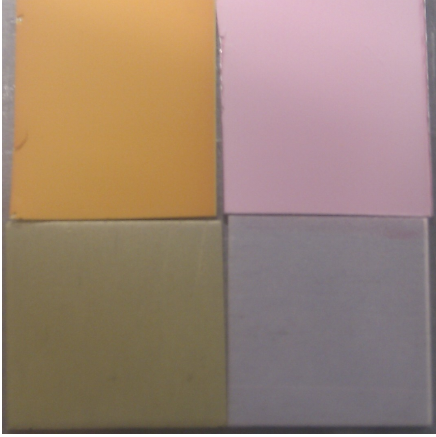
Figure 6. Comparison of Porous Samples. Clockwise from top right: PtTFPP TLC, PtTFPP AA, Ru(dpp) AA, Ru(dpp) 3 3